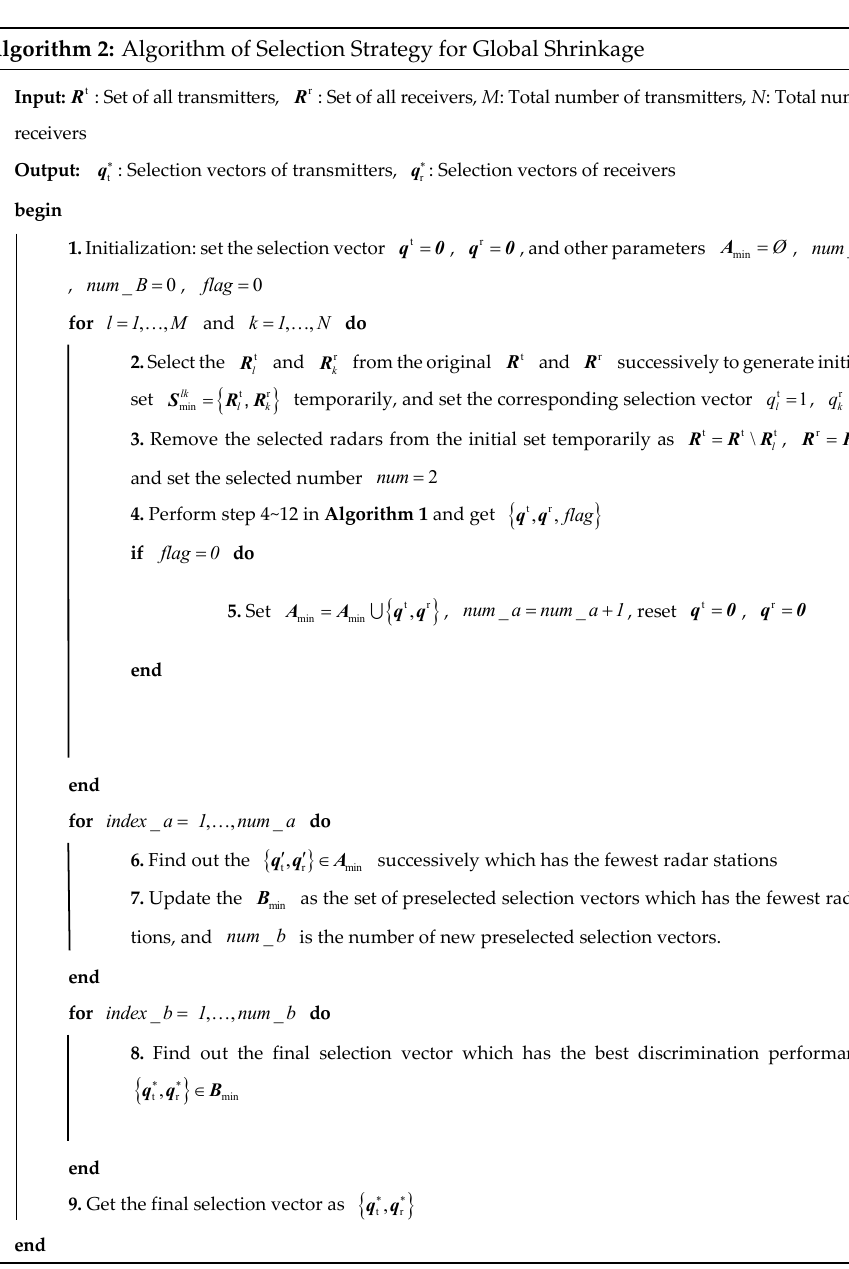
Algorithm 2: Algorithm of Selection Strategy for Global Shrinkage